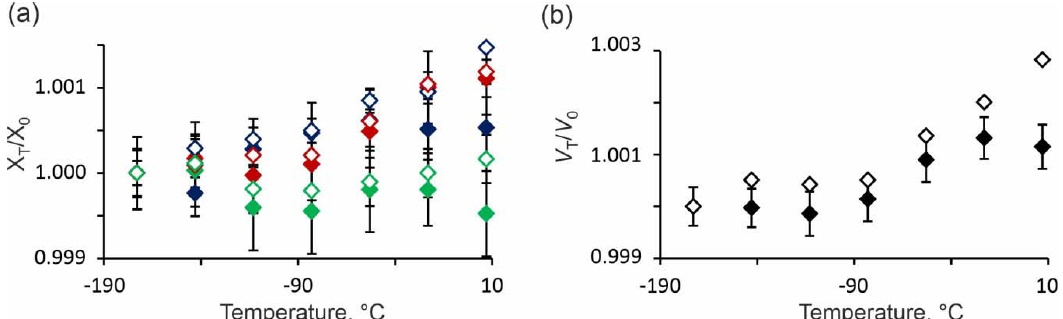
Figure 9. Normalized unit-cell parameters ( a ) and volumes ( b ) for hingganite-(Y) (filed symbols) and datolite (open symbols). Blue symbols demonstrate a parameters, red: b , green: c . The normalized parameters for datolite were calculated using data from [20].